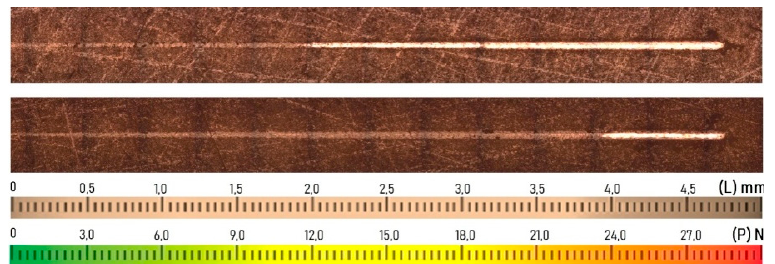
Figure 7. Tracks of indenter movements on the surface of 6WH10F hard alloy samples with DLCs and corresponding loads from 1 to 30 N; coating without sublayer (upper image), coating with sublayer (CrAlSi) N (lower image).